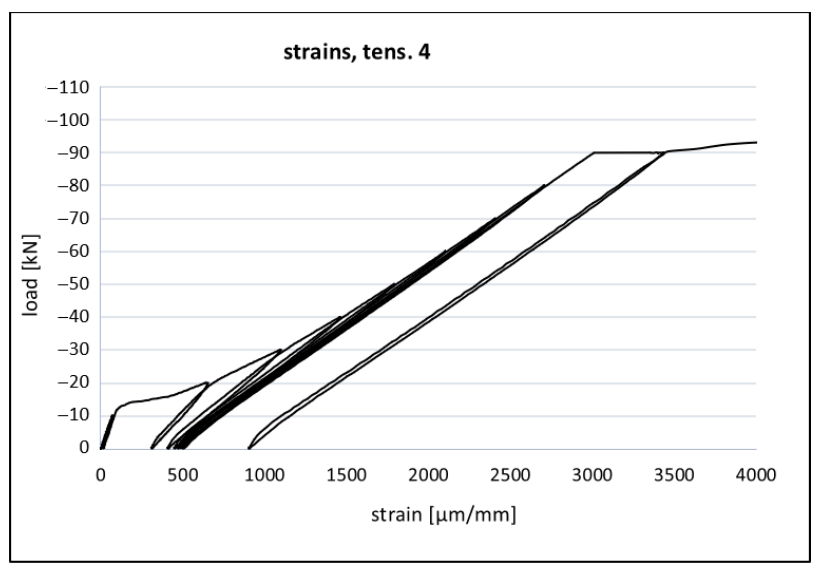
Figure 13. Experimental relationship between strain and load of a reinforcing bar (beam of the series Vc — tensometer N o 4 on the bar).